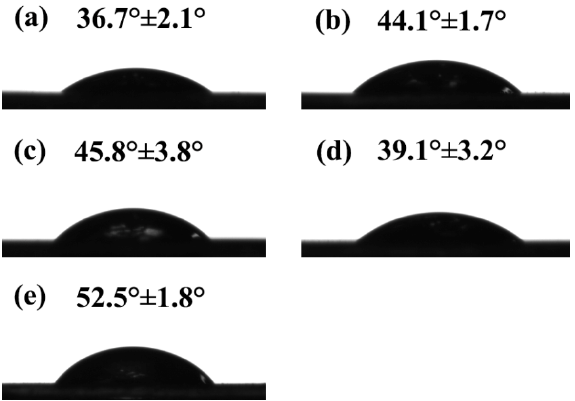
Figure 9. WCA values of ( a ) SPI, ( b ) SPI/G, ( c ) SPI/CNT, ( d ) SPI/NFC, and ( e ) SPI/G/CNT/NFC series films.